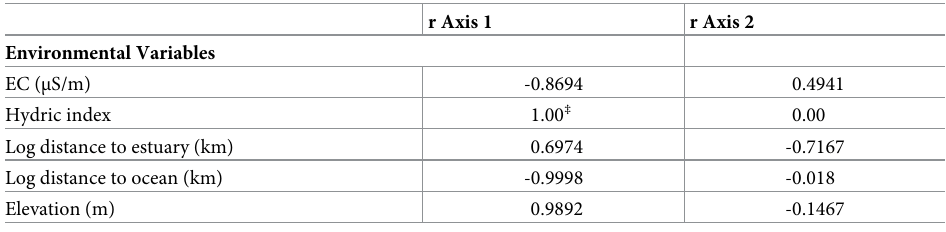
Table 1. Pearson correlation between site variables and the NMS ordination